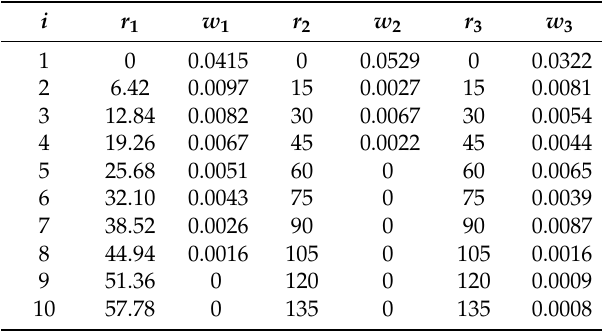
Table 2. Parameters of tripartite PI model. ( i is the number of sampling point, r 1 is the threshold of